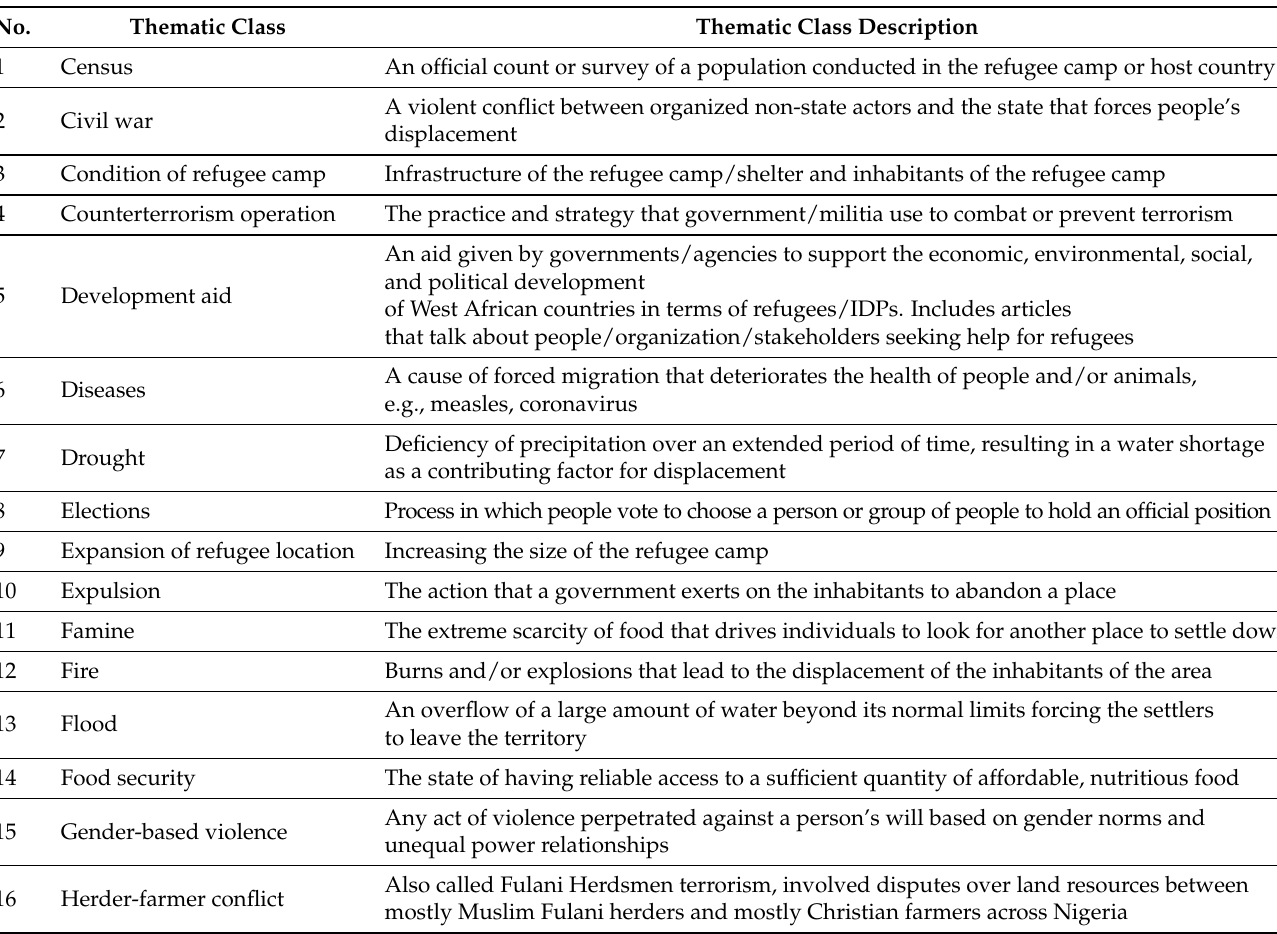
Table 2. Identified thematic classes in the WARRe dataset and their